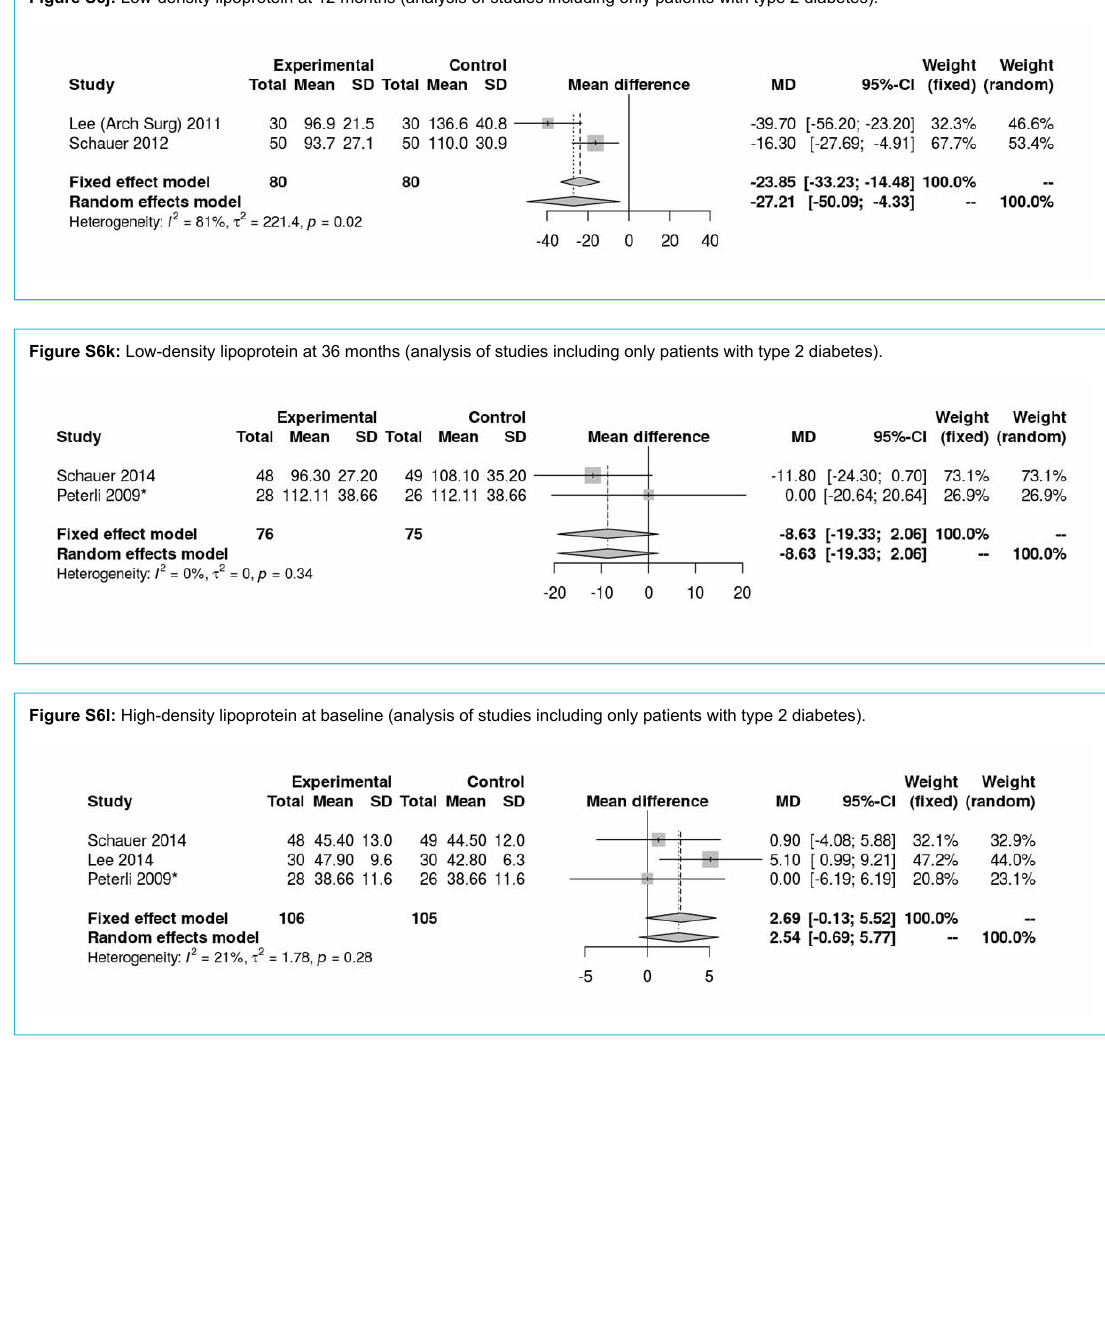
Figure S6j: Low-density lipoprotein at 12 months (analysis of studies including only patients with type 2 diabetes).